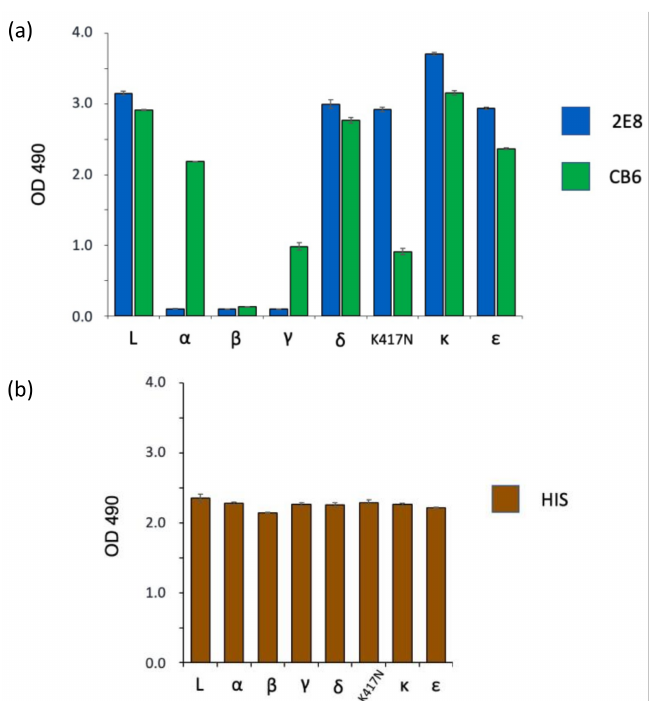
Figure 4. Differential recognition of SARS-CoV-2 variant spike antigens using a sandwich ELISA with human mAbs. The mAbs were adhered to the ELISA plate and tested for capture of soluble spike antigen. Bound antigen was detected with the mouse anti-S1 mAb. ( a ) Both 2E8 and CB6 are compared. ( b ) An anti-His tag capture antibody was used as a positive control. Antigens used (same as Figure 3): L RBD (Wuhan-Hu-1), α S1 (B.1.1.7), β S1 (B.1.351), γ S1 (P.1), δ RBD (B.1.617.2), K417N RBD, κ RBD (B.1.617.1), ε S1